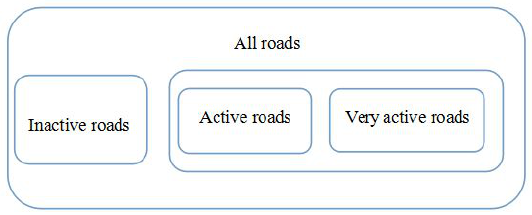
Figure 2. The schematic diagram of road